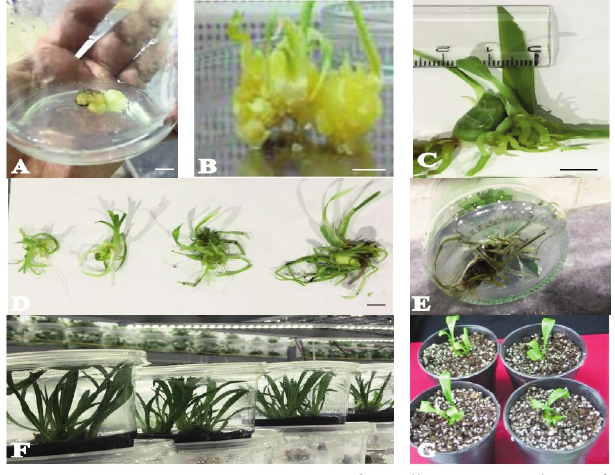
Fig. 3 ­ Micropropagation process of Fritillaria imperialis L. A) Callus production on bulb scales. B) Leaves produced from callus by indirect organogenesis. C) Developed lea­ ves before planting in greenhouse condition. D) Regenerated plantlets from callus on media containing different concentrations of KIN and NAA. E) Rooted plan­ tlets. F) Regenerated leaves in media supplemented with different concentrations of KIN and NAA. G) Acclimatization of plantlets grown into the pots filled with peat moss and perlite (1:1) in an adaptation greenhouse (scale bar = 10